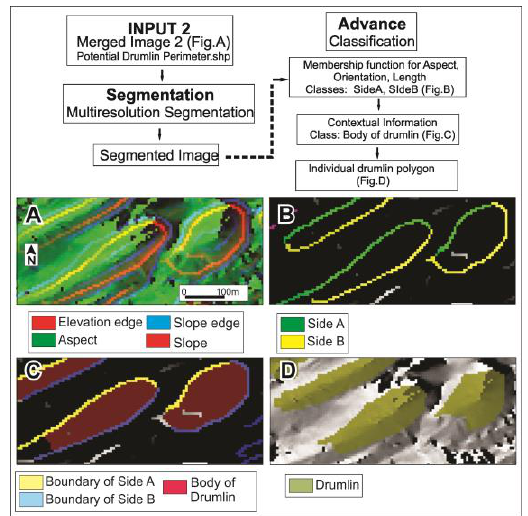
Figure 8. A. “Merged Image 2”; B. The slope gradient was then analyzed via the MS Segmentation, C. Classified image with 3 classes, D. Individual polygon for each drumlin.